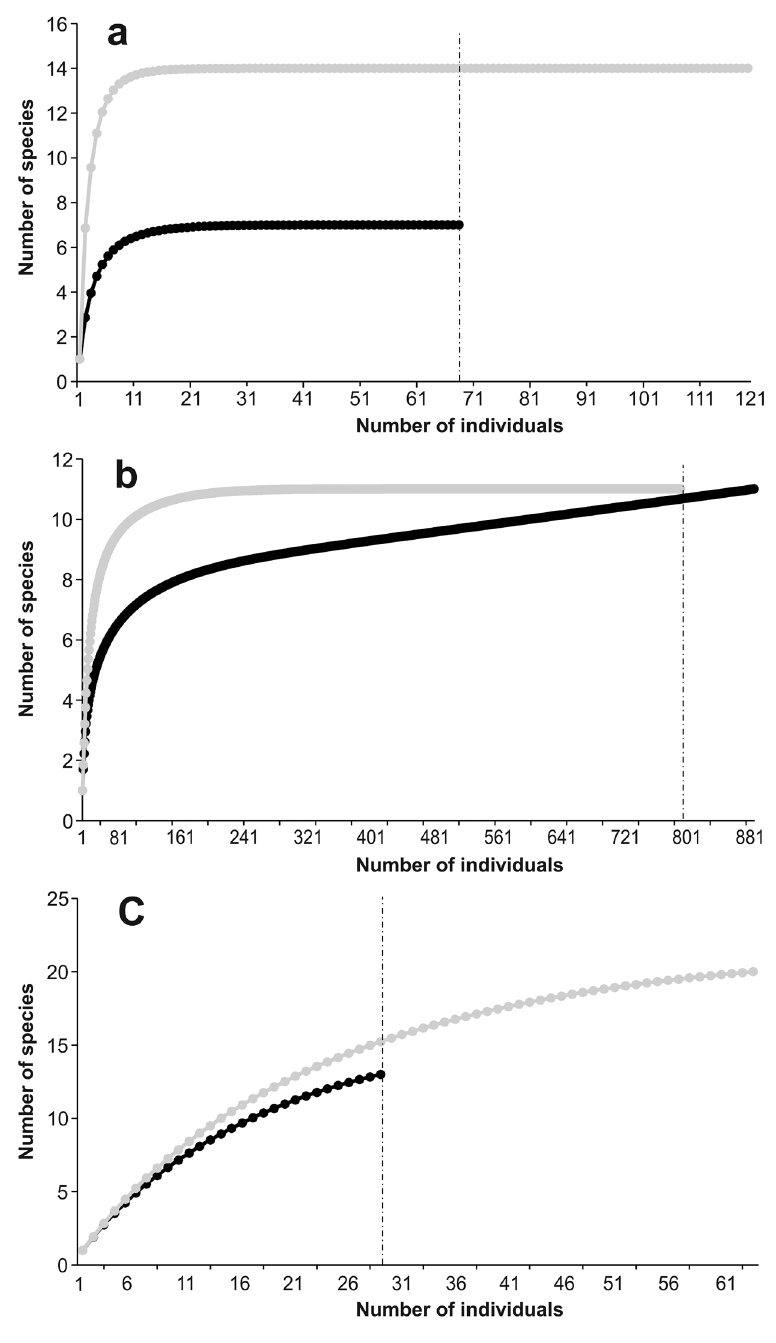
Figure 6. Rarefaction curves of species of amphibians ( a ), lizards ( b ), and snakes ( c ). Richness is com- pared inside black line and outside gray line of REBSSJ. Vertical line refers to the minimum number of individuals between